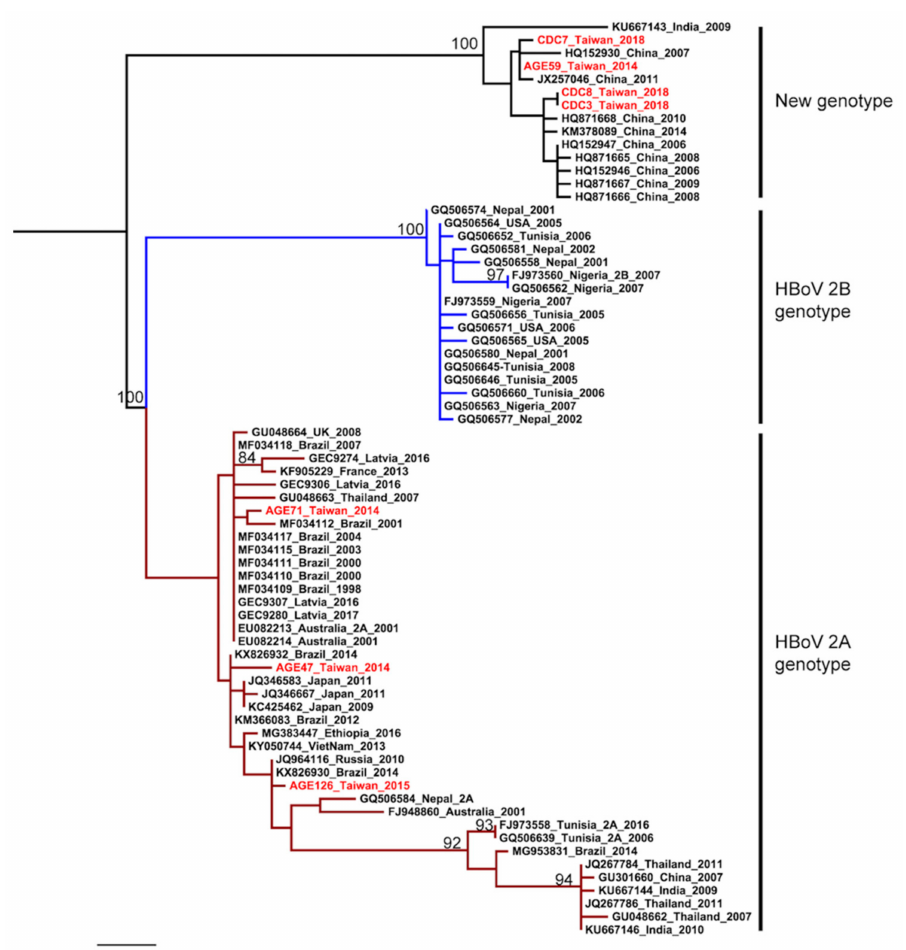
Figure 1. Phylogenetic analysis of human bocavirus 2 using the maximum likelihood method. The phylogenetic tree was reconstructed based on the HBoV2 partial VP1 gene. The stability of the tree topology was evaluated by using 1000 bootstrap replicates. Only bootstrap values greater than 75% are shown on the branch. The red texts represent HBoV2 isolates in Taiwan from the children with AGE. Brown and blue clades are represented HBoV2A and HBoV2B,